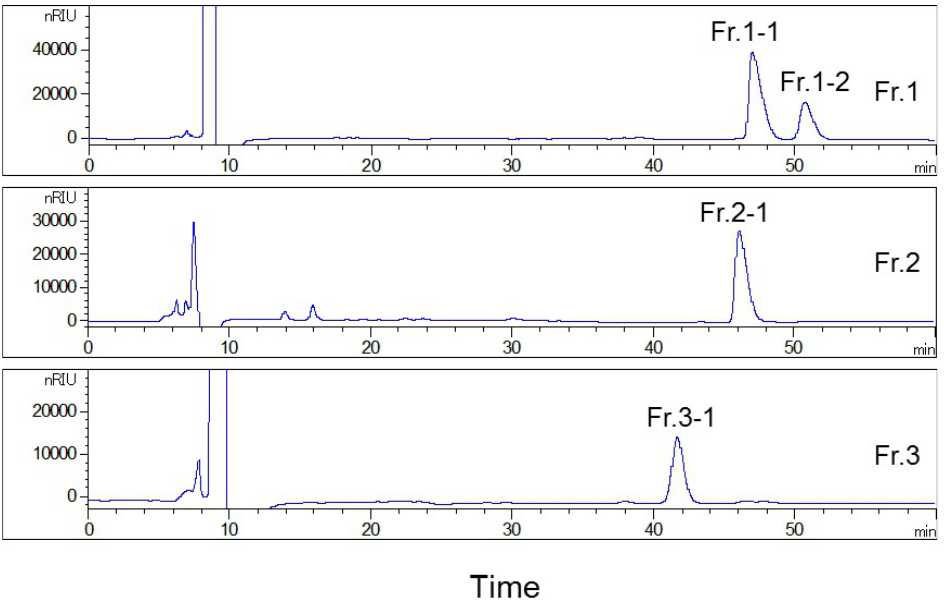
Figure 3. HPLC preparation chromatograms of fractions collected during the first HPLC separation on the YMC-Pack ODS-AQ column (250 × 10 mm). Conditions: mobile phase: water–acetonitrile (82:18, v/v); flow rate: 2.0 mL/min; column temperature: 30 °C.